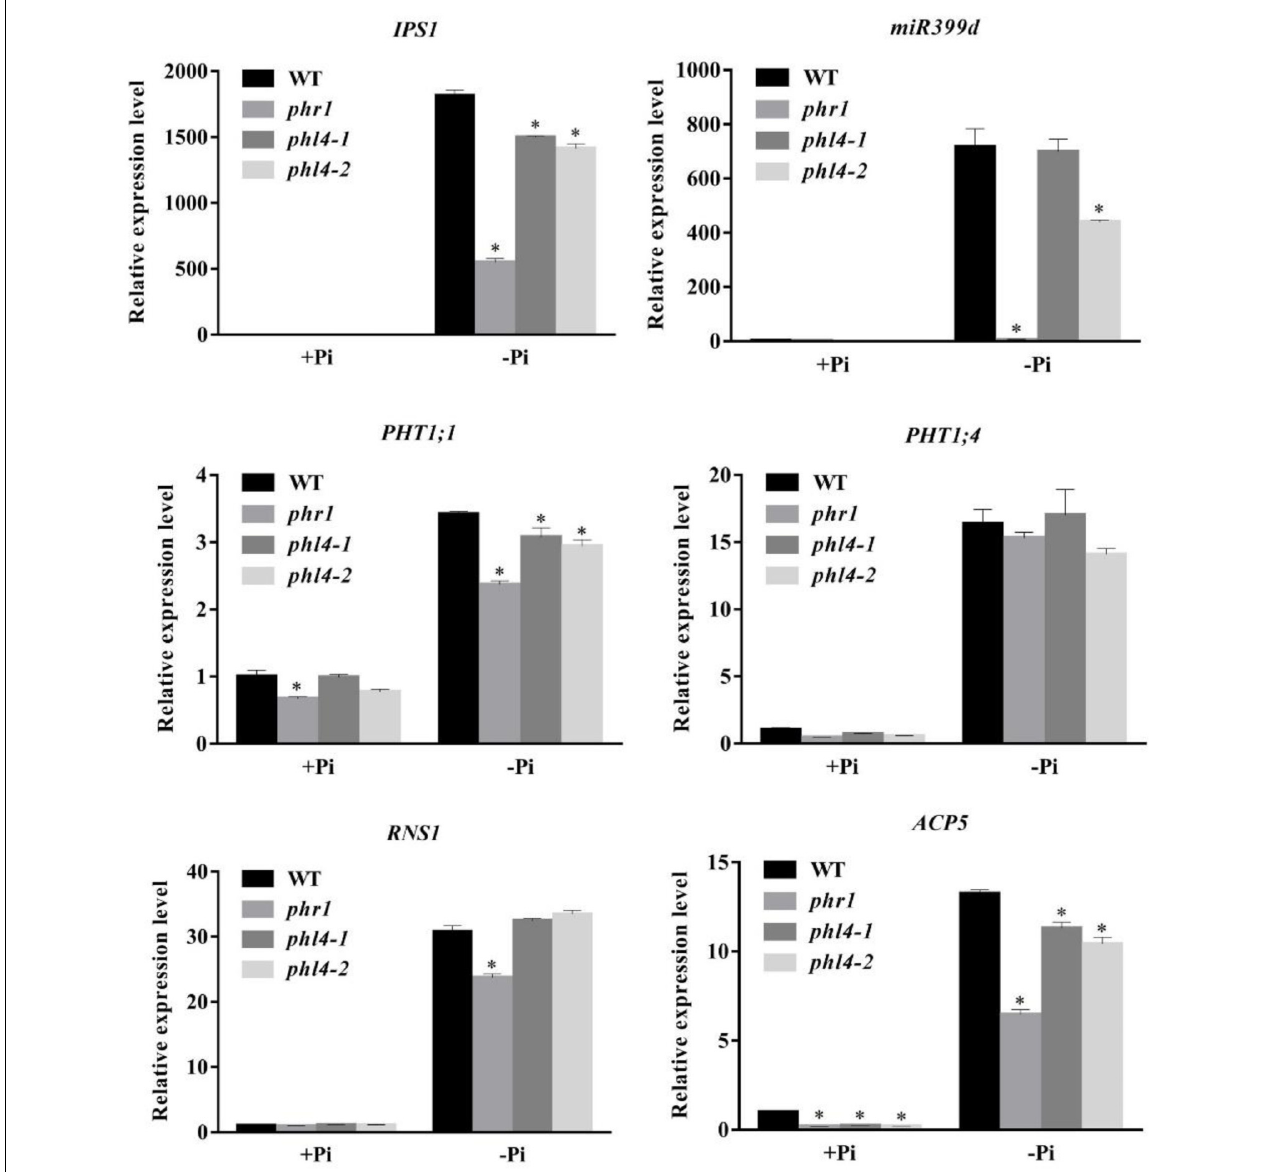
FIGURE 5 | Analyses of PSI gene expression in the WT, phr1 , phl4-1 , and phl4-2 . Roots of 8-day-old seedlings of the WT and other mutants grown on +Pi and –Pi media were used for qPCR analysis. The names of the genes examined are indicated on the top of each panel. Values are the means ± SD of three biological replicates and represent fold changes normalized to transcript levels of the WT on +Pi medium. Means with asterisks are significantly different from the WT ( P < 0.05, t -test).